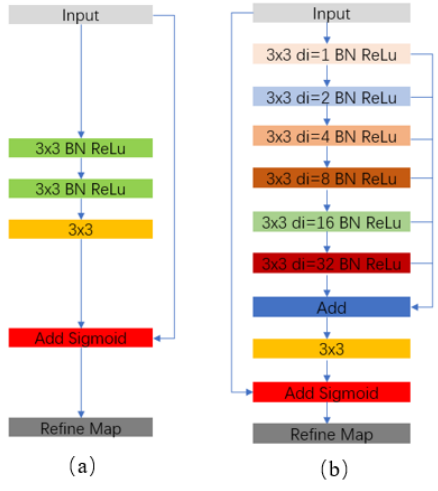
Figure 3. Comparison of: ( b ) the structure of RRM_Bu proposed in this paper; and ( a ) the structure of RRM_Lc proposed in [37], and di represents dilation